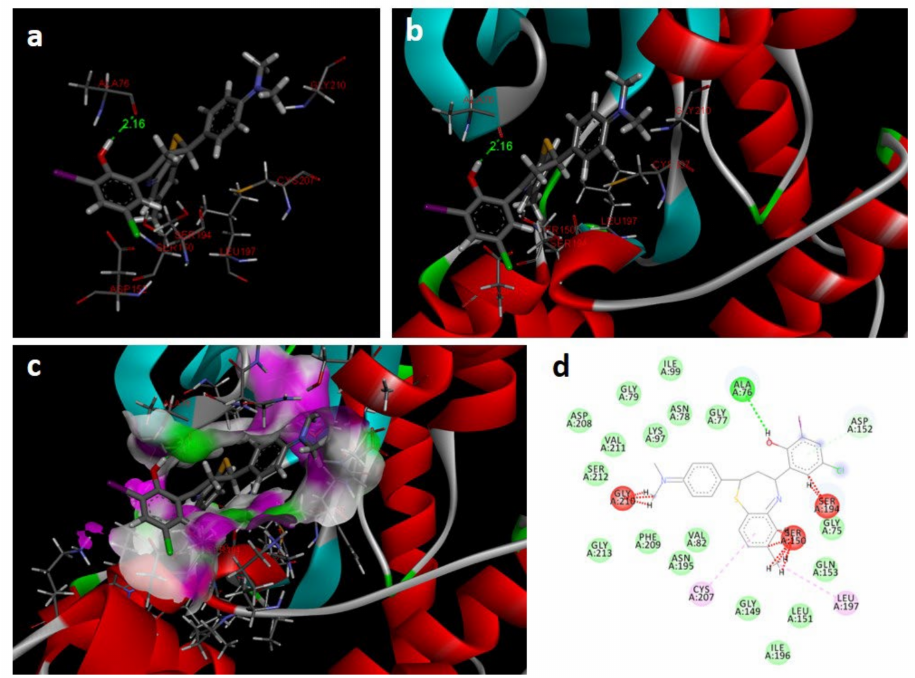
Figure 8. Docking images of 2c with 3w8q: ( a ) H-bonds between 2c and protein residues; ( b , c ) 3d representation of interactions in the binding cavity; ( d ) 2D representation of interactions in the binding